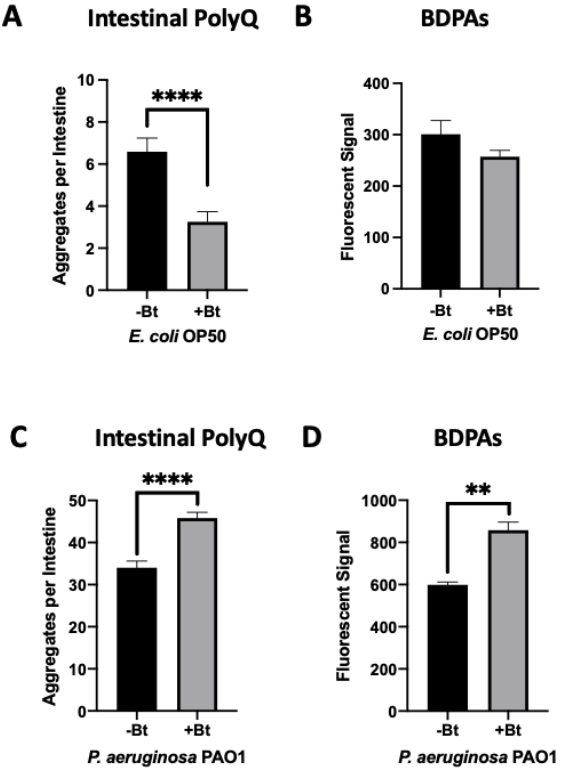
Figure 2. Low-concentration butyrate increases the abundance of P. aeruginosa BDPAs, which con- tributes to polyQ aggregation in C. elegans . The effect of ( A ) E. coli OP50 and ( C ) P. aeruginosa PAO1 colonization of the C. elegans intestine on polyQ aggregation in the absence (-Bt) and presence (+Bt) of 12.5 mM butyrate. Data are represented as the average number of polyQ aggregates per C. elegans intestine. Each data point is an average of three independent experiments with a total of 60 worms. ProteoStat assay quantification of total protein aggregates produced by ( B ) E. coli OP50 and ( D ) P. aeruginosa PAO1 in the absence (-Bt) and presence (+Bt) of butyrate. Data are represented as the average ProteoStat fluorescent signal per bacterial strain per treatment. Each data point is an aver- age of two independent experiments with three replicates per run. A-D) Error bars represent SEM. Statistical significance was calculated using Student’s t -test (** p < 0.01, **** p < 0.0001).